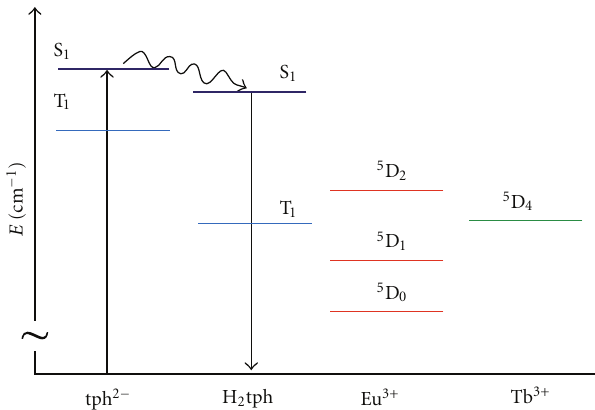
Figure 10: Simplified energy diagram showing the energy levels of tph 2 − , H 2 tph along with Eu 3+ and Tb 3+ .